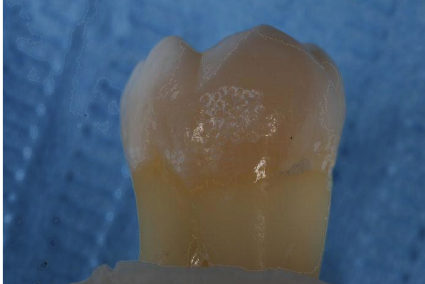
Figure 3: Enamel surface after conditioning with Er:YAG